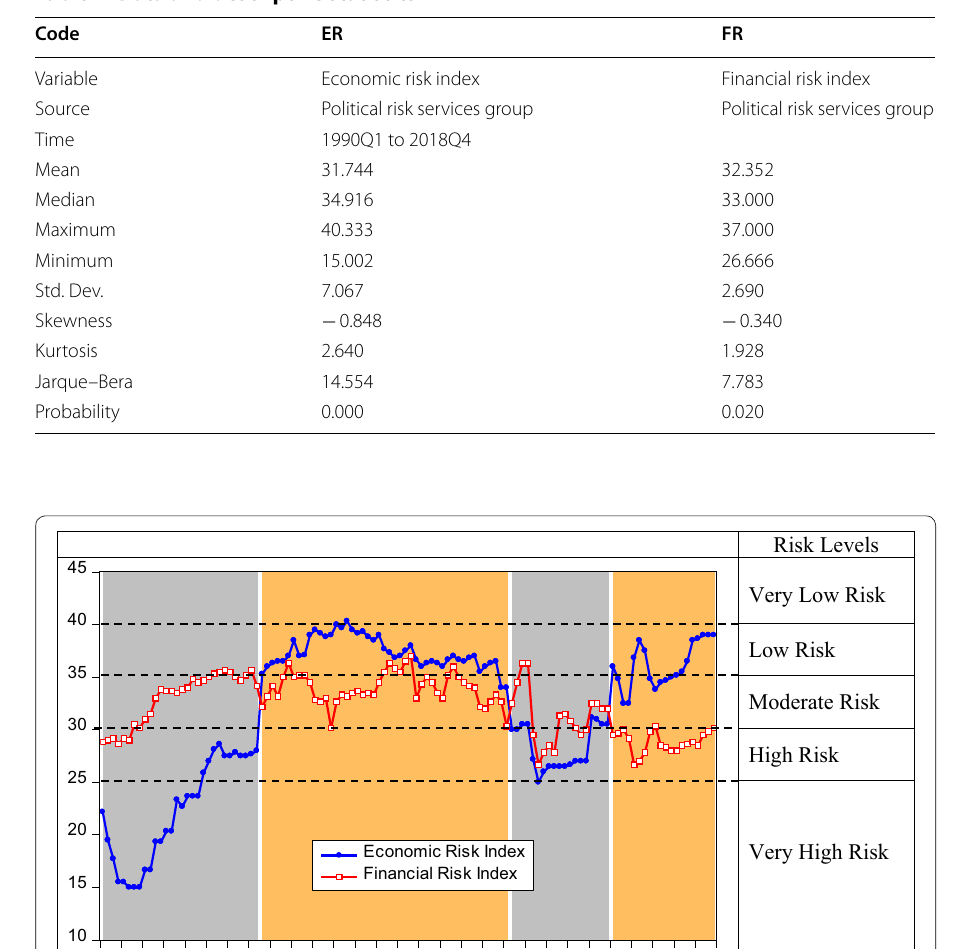
Table 1 Data and descriptive statistics